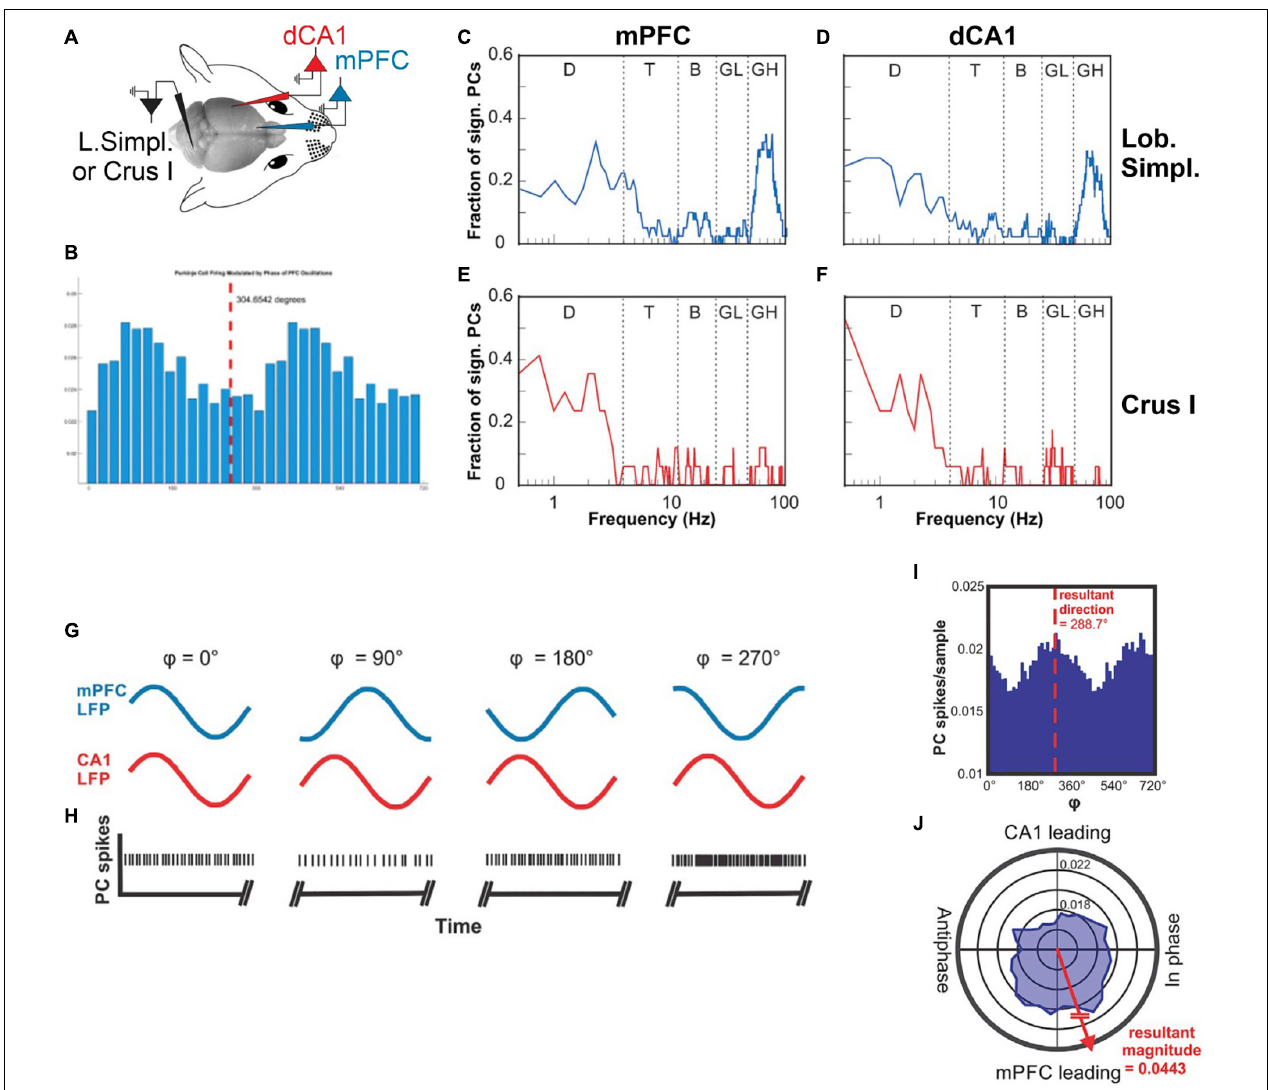
FIGURE 3 | Cerebellar representations of phase and phase differences of oscillations in the mPFC and CA1. (A) Illustration of the experimental setup with recording electrodes in the mPFC and dCA1, picking up LFPs and a recording electrode in cerebellar lobulus simplex recording single unit Purkinje cell spike activity. (B) Example histogram showing Purkinje cell simple spike rate plotted against the phase of a 10 Hz oscillation recorded in the mPFC. (C) Fraction of Purkinje cells in LS ( n = 32) whose simple spike activity was significantly correlated with oscillatory phase plotted as a function of mPFC oscillation frequency (plotted on a log-10 scale). The function shows two peaks at the delta frequency range (0.5–4 Hz) and the high gamma range (50–100 Hz). (D) As in (C) but showing fractions of LS Purkinje cells significantly modulated by the phase of oscillatory activity in CA1. (E) Fraction of Purkinje cells in Crus I ( n = 17) whose simple spike activity was significantly correlated with the oscillatory phase in mPFC plotted as a function of mPFC oscillation frequency. The function shows a single peak at the delta frequency range (0.5–4 Hz). (F) As in (E) but showing fractions of Crus I Purkinje cells significantly modulated by the phase of oscillatory activity in CA1. D, delta; T, theta; B, beta; LG, low gamma; HG, high gamma. (G) Illustration of hypothetical oscillations at a specific frequency occurring simultaneously in the mPFC (blue traces) and CA1 (red traces) and displaying different phase relationships (4) at different times. The phase relationship 4 is defined as the phase difference relative to the mPFC oscillation. (H) Hypothetical Purkinje cell spikes recorded simultaneously with the LFP activity in the mPFC and CA1 shown in (G) . The rate modulation of this hypothetical Purkinje cell shows a significant increase in spike firing when the phase difference between mPFC and CA1 oscillations reaches values around 270 ◦ . (I) Phase histogram of real Purkinje cell simple spike activity. The histogram shows spike activity as a function of mPFC-CA1 phase differences at 11 Hz. The simple spike activity of the Purkinje cell in this example was significantly modulated as a function of mPFC-CA1 phase difference, with a preference of 288.7 ◦ . (J) Same data as in (I) represented in polar coordinates. Vectors composed of the angular value 4 and the magnitude of the spikes per sample were summated to determine the angular preference of Purkinje cell activity. The resultant vector magnitude was taken to quantify the degree of modulation and tested against surrogate results for statistical significance (from McAfee et al.,